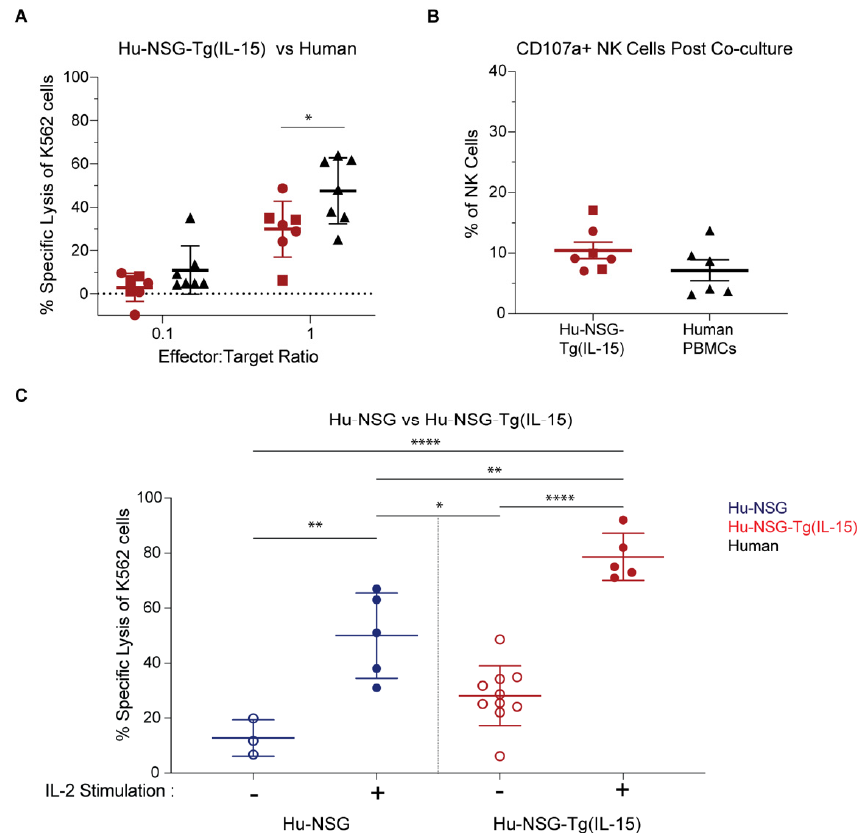
Figure 5. Hu ‐ NSG ‐ Tg(IL ‐ 15) ‐ derived NK cells are cytotoxic. ( A ) Calcein release assay with spleno ‐ cytes from Hu ‐ NSG ‐ Tg(IL ‐ 15) or human PBMCs co ‐ cultured with K562 cells at 1:10 or 1:1 effector ‐ to ‐ target ratio. ( B ) Hu ‐ NSG ‐ Tg(IL ‐ 15) mouse splenocytes or human PBMCs were stained with anti ‐ CD107a antibody after 4 h co ‐ culture with K562 cells. CD107a + expressing NK cells (hCD45 + mCD45 ‐ CD3 ‐ CD56 + CD107a + ) as a percentage of total NK cells is presented. Hu ‐ NSG ‐ Tg(IL ‐ 15) ( n = 7, 2 un ‐ related donors) and 6 human donors. Mice reconstituted from unrelated human donor cord ‐ blood ‐ derived CD34 + stem cells are denoted by different symbols. ( C ) Calcein release assay with spleno ‐ cytes from Hu ‐ NSG ( n = 3 ‐ 5, 1 donor) and Hu ‐ NSG ‐ Tg(IL ‐ 15) ( n = 5 ‐ 10 , 1 ‐ 2 donors) co ‐ cultured with K562 cells at 1:1 effector ‐ to ‐ target ratio with or without IL ‐ 2 stimulation. Splenocytes from all mice